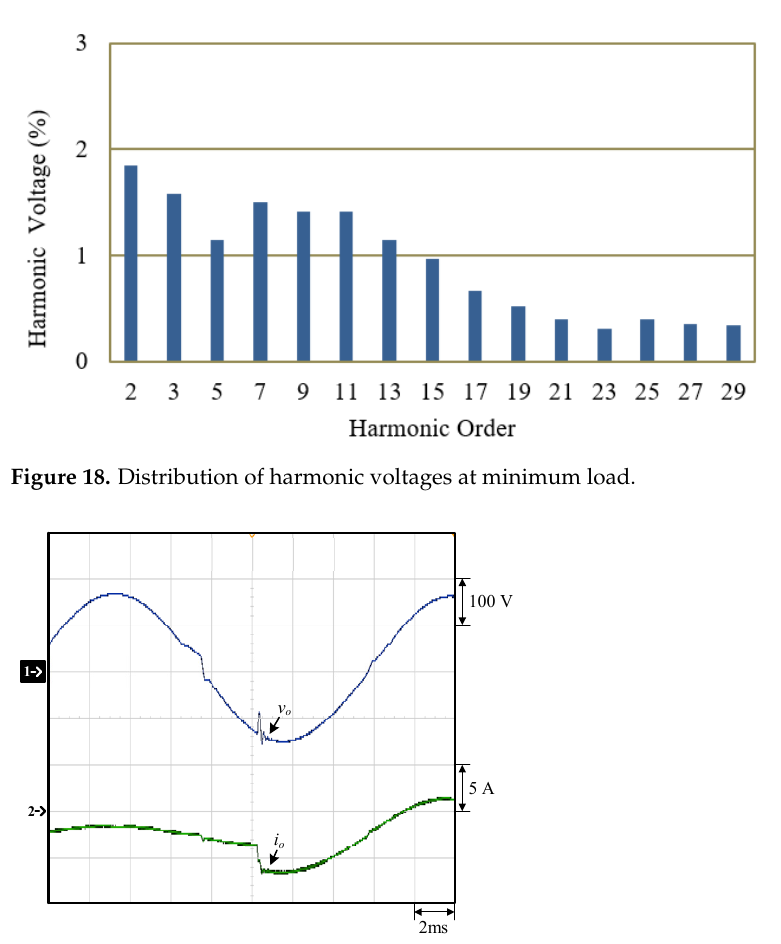
Figure 17. Distribution of harmonic voltages at rated load.